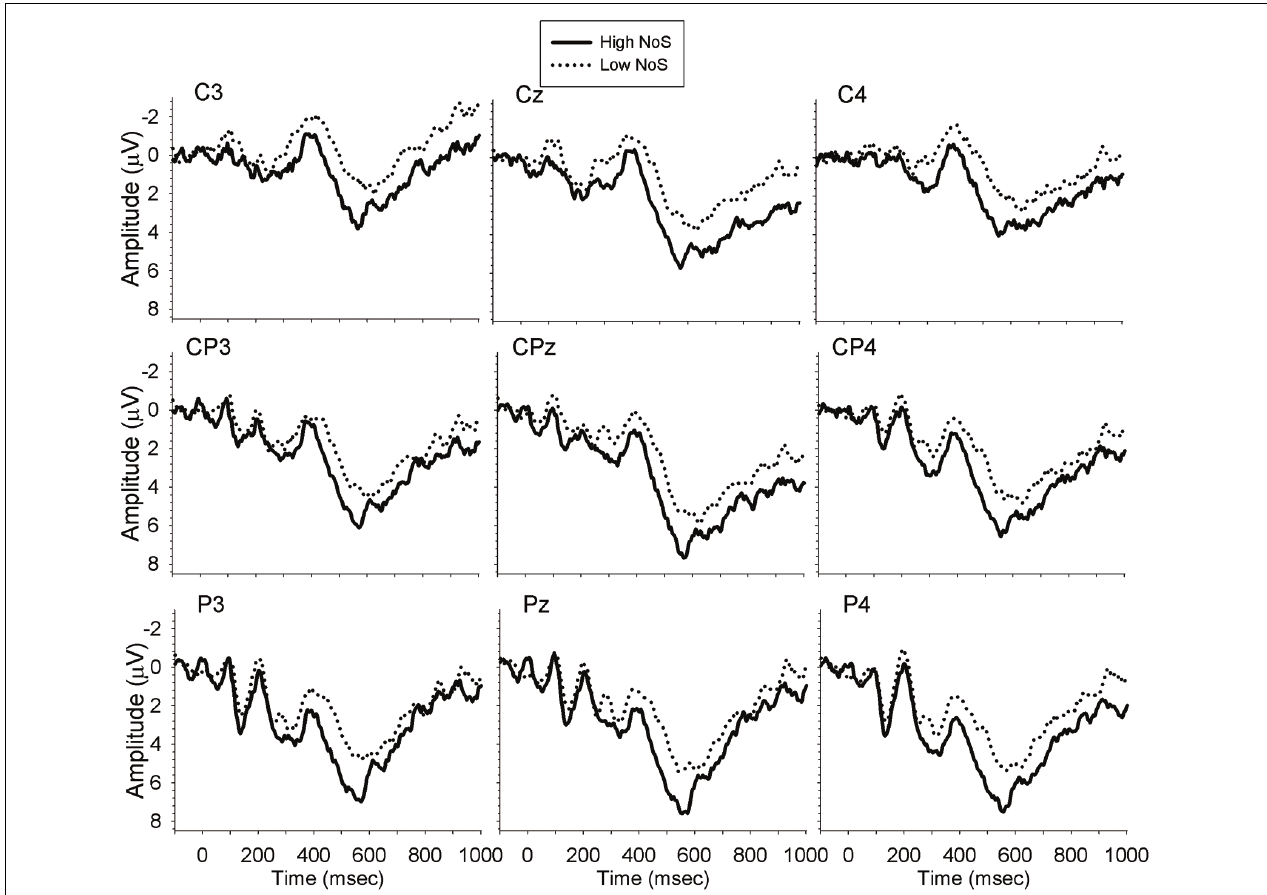
FIGURE 4 | Waveforms elicited by bilinguals performing the task in